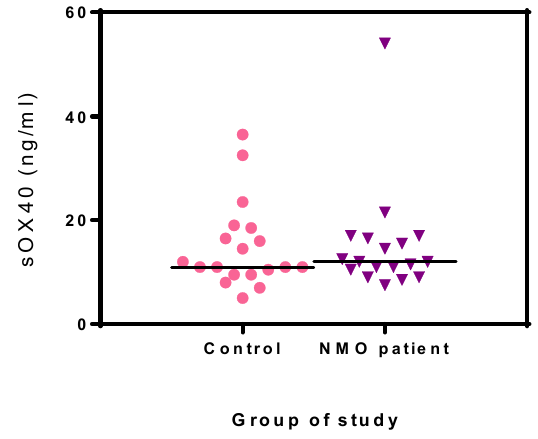
Figure 1: Serum sOX40 levels. There were no significant differences in sOX40 serum levels when comparing NMO patients with controls (p = 0.37). Values shown are means ± SD of 20 subjects/group.